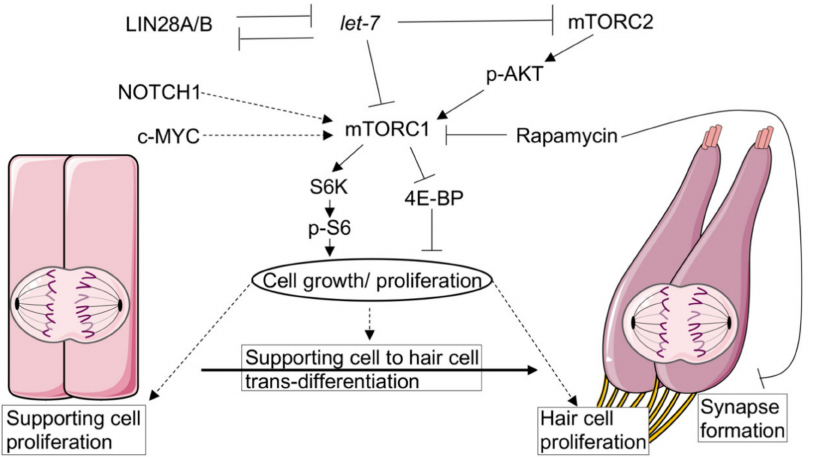
Figure 2. mTOR signaling in auditory sensory hair cell regeneration. mTORC1 is involved in supporting cell proliferation and hair cell (re)generation, effects that can be inhibited by rapamycin. Moreover, rapamycin inhibits inner hair cell synapse maturation at postnatal ages. mTORC2 might also be involved in hair cell generation, since p-AKT decreases when hair cell generation is lost but increases again when the regenerative capacity is regained. Dashed lines indicate unknown mechanisms. The figure was created with Servier Medical Art templates by Servier, which are licensed under a Creative Commons Attribution 3.0 Unported License; https://smart.servier.com (accessed on 16 January